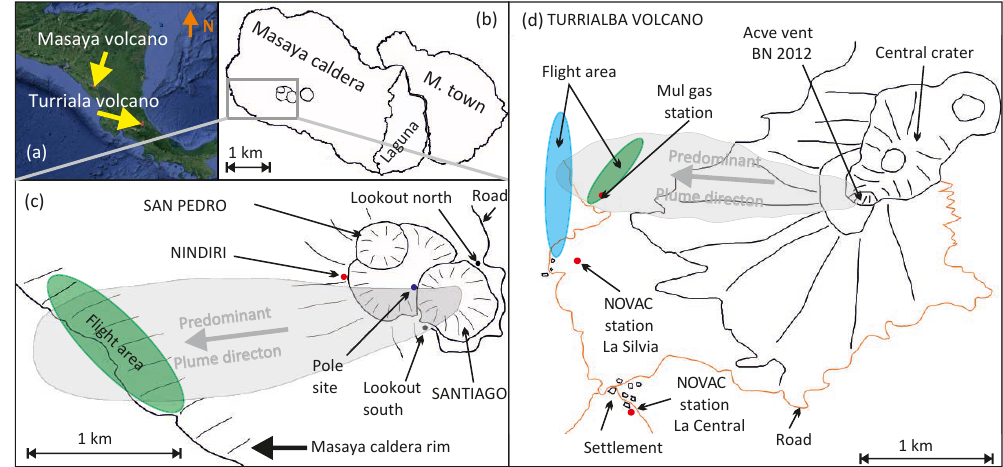
Figure 2. Overview of the fieldwork sites at (a–c) Masaya volcano (Nicaragua) and (d) Turrialba volcano (Costa Rica). Sampling locations mentioned in Table 3 are marked in (c) as follows: Santiago rim, lookout south (black marker); Santiago rim, pole site (blue marker); Nindiri rim (red